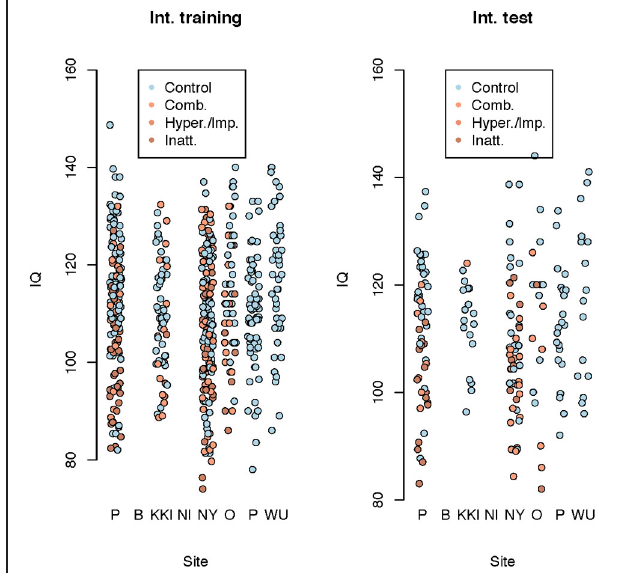
FIGURE 4 | Dot plot of composite intelligence quotients (average of all available IQ measurements per subject) by data contributing site color coded by disease subtype for the internal training set and internal test set.